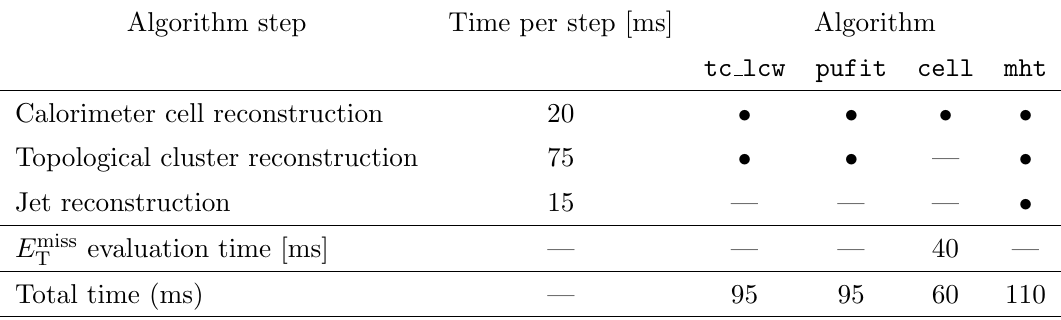
in the HLT online farm. The T